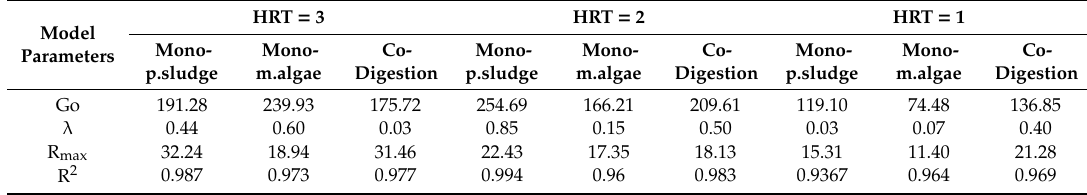
Table 5. Kinetic model parameters (after 85 ◦ C anaerobic